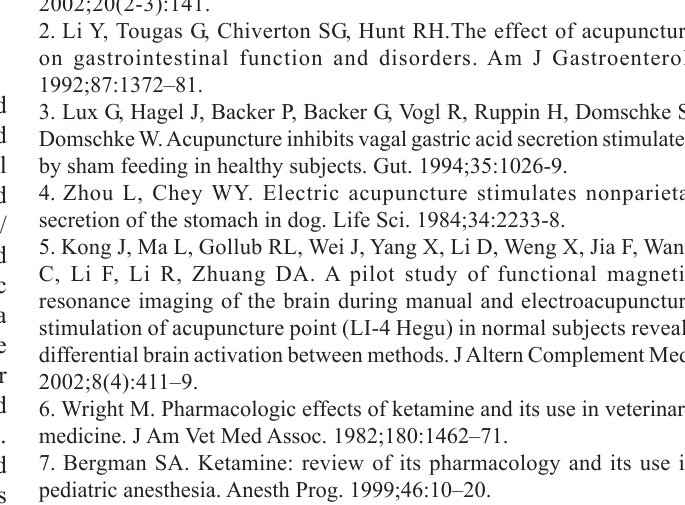
FIGURE 1 - Weight of the rats (gram). Bars represent mean ±SEM of BV (yellow), AC (green), EAC10 (blue) and EAC100 (red) groups. Values are not significantly different from each other group by ANOVA